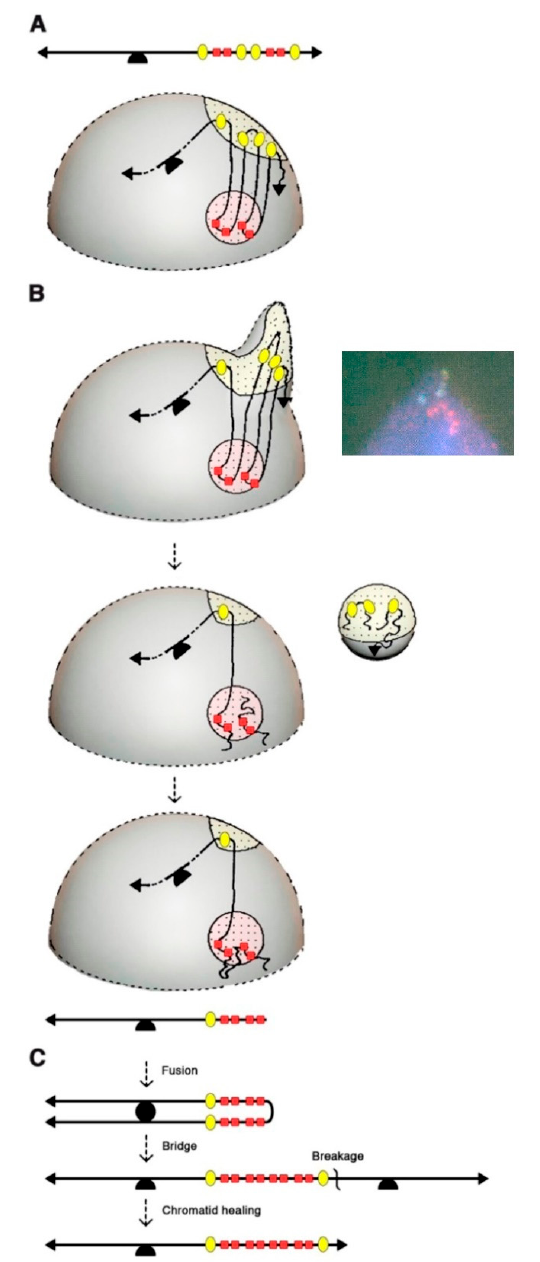
Figure 3. The interphase breakage model, integrating micronucleation, multiple DNA breaks and BFB cycles, can explain the rapid evolution of amplified chromosomes. ( A ) Co-amplified markers alternating in metaphase chromosomes (top) may segregate in interphase nuclei (bottom) into distinct nuclear domains (dotted areas). Red squares: amplification driver gene; yellow ovals: passenger marker; arrowheads: telomeres; half-circle: centromere. ( B ) The co-amplification of sequences belonging to distinct nuclear domains may perturb nuclear architecture, and lead to the extrusion of passenger sequences in a micronucleus. Micronucleus extrusion is associated with multiple DNA breaks, and the DNA fragments retained in the nucleus are stitched together to generate an amplified chromatid with an excess of driver sequences. ( C ) The amplified chromatid lacks a telomere and may undergo further BFB cycle(s). In ( B ) a typical nuclear malformation from an AMPD2-amplified cell analyzed by FISH is shown. Extra-copies of AMPD2 (in red) and P3C4 (in yellow) segregate into distinct domains, and the nuclear bulge only contains P3C4 copies. Adapted from Figures 3 and 5 of Ref.